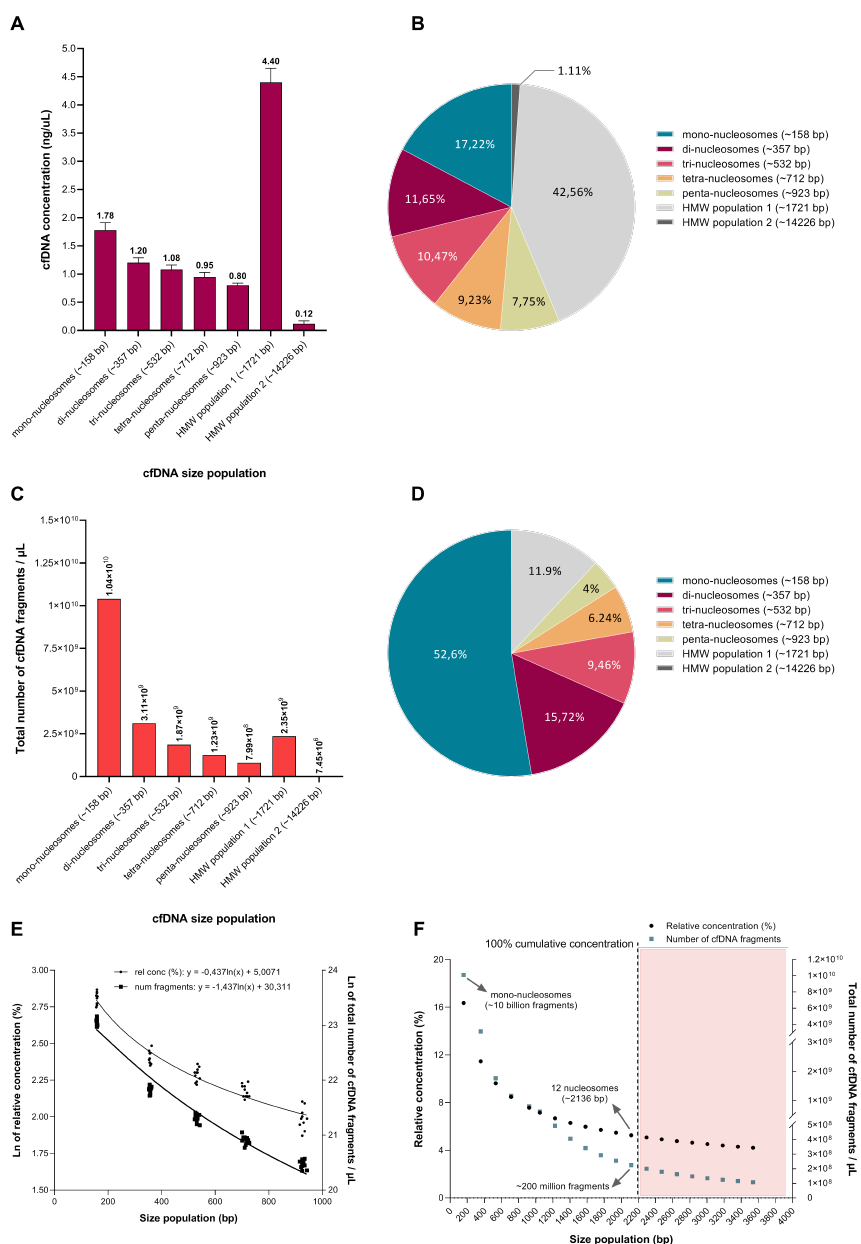
Figure 5. Characterization of differently sized cell-free DNA (cfDNA) populations as determined by the dsDNA 930 assay. Summary of the ( A ) average concentration, ( B ) relative contribution (%) in terms of concentration, ( C ) copy number (total number of cfDNA fragments) frequency distribution and ( D ) relative contribution (%) in terms of the copy number of the differently sized cfDNA populations present in the cell culture supernatant as determined by the dsDNA 930 assay. The total number of individual fragments that constitute each of the differently sized cfDNA populations (copy number) was determined as follows: (i) calculate the total number of base pairs that constitute each size population by dividing the average concentration of the population by the theoretical weight of one base pair (650 Da = 1.67 × 10 − 24 g); and (ii) divide the total number of base pairs by the corresponding modal length of the population. ( E ) Logarithmic equations obtained by the relative concentration (%) (left y axis) and total number of cfDNA fragments (right y axis), respectively, of the different size populations in several tested samples ( n = 11) were used to ( F ) forecast the average length (left y axis) and total number of fragments (right y axis) that constitute the largest nucleosome population that may be present in the samples measured in this